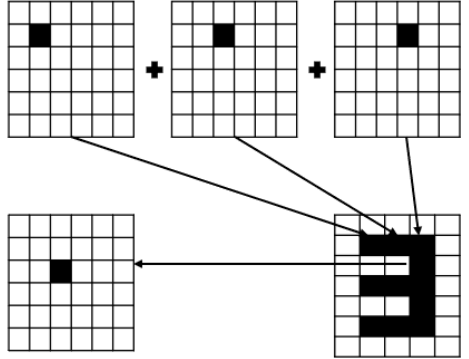
Figure 2. Complex goal and basic elements relationship.